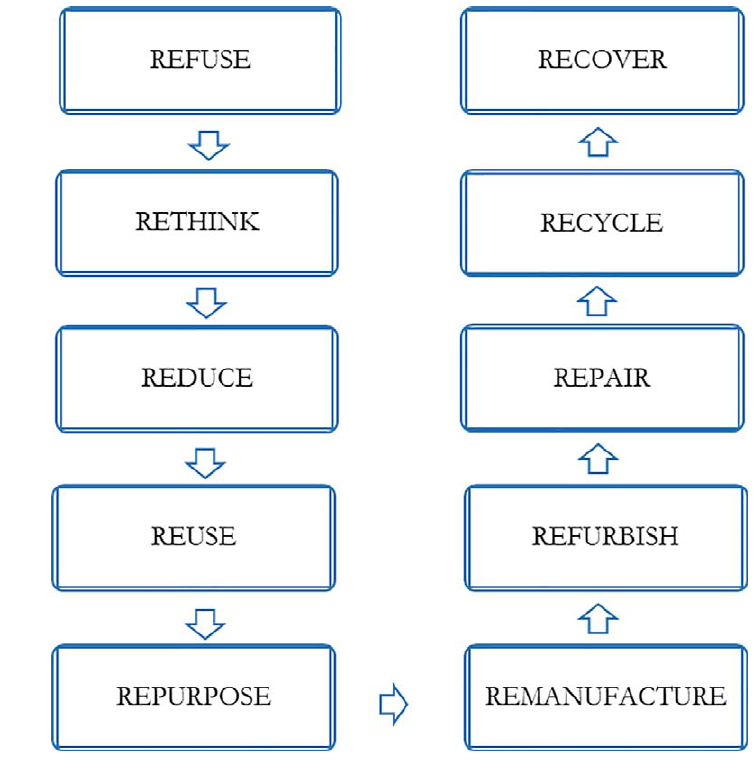
Figure 2. R’s of